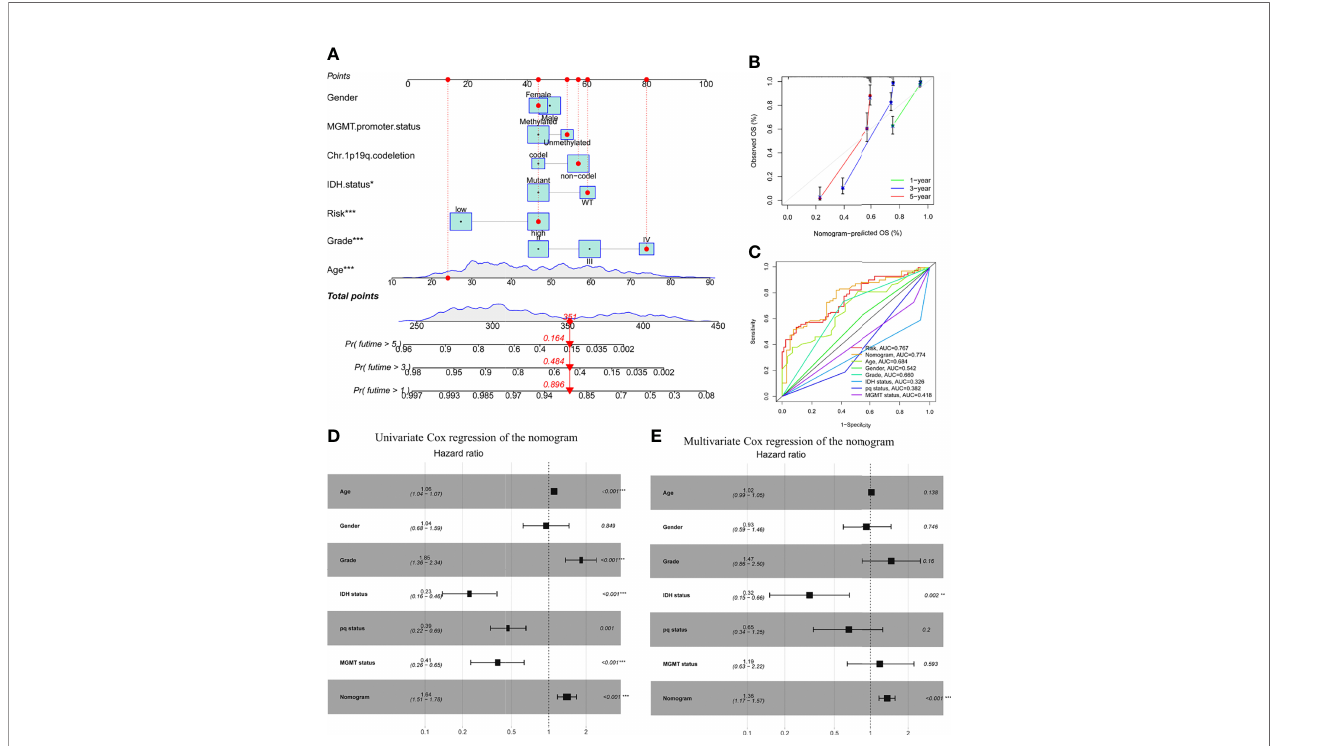
FIGURE 5 | Prognostic ef fi cacy of risk score in OS of patients from the TCGA cohort when combined with clinical-pathological features. (A) Nomogram indicates OS in the TCGA cohort of patients. (B) The nomogram ’ s calibration plots. The y-axis represents actual survival, whereas the x-axis represents nomogram-predicted survival. (C) Receiver operating characteristic charts for risk score and clinical features. (D, E) The nomogram ’ s univariate and multivariate Cox regression analyses. *p < 0.05; **p < 0.01; ***p < 0.001..